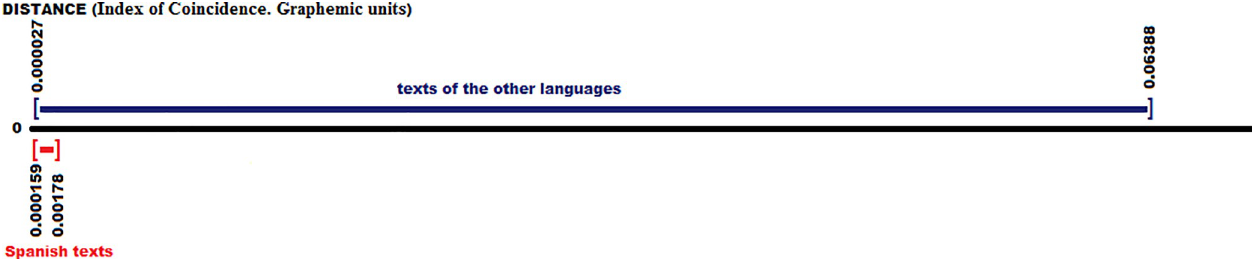
Fig 10. Index of Coincidence of the texts in Spanish or Castilian (graphemic units) (red) versus the other texts (blue).